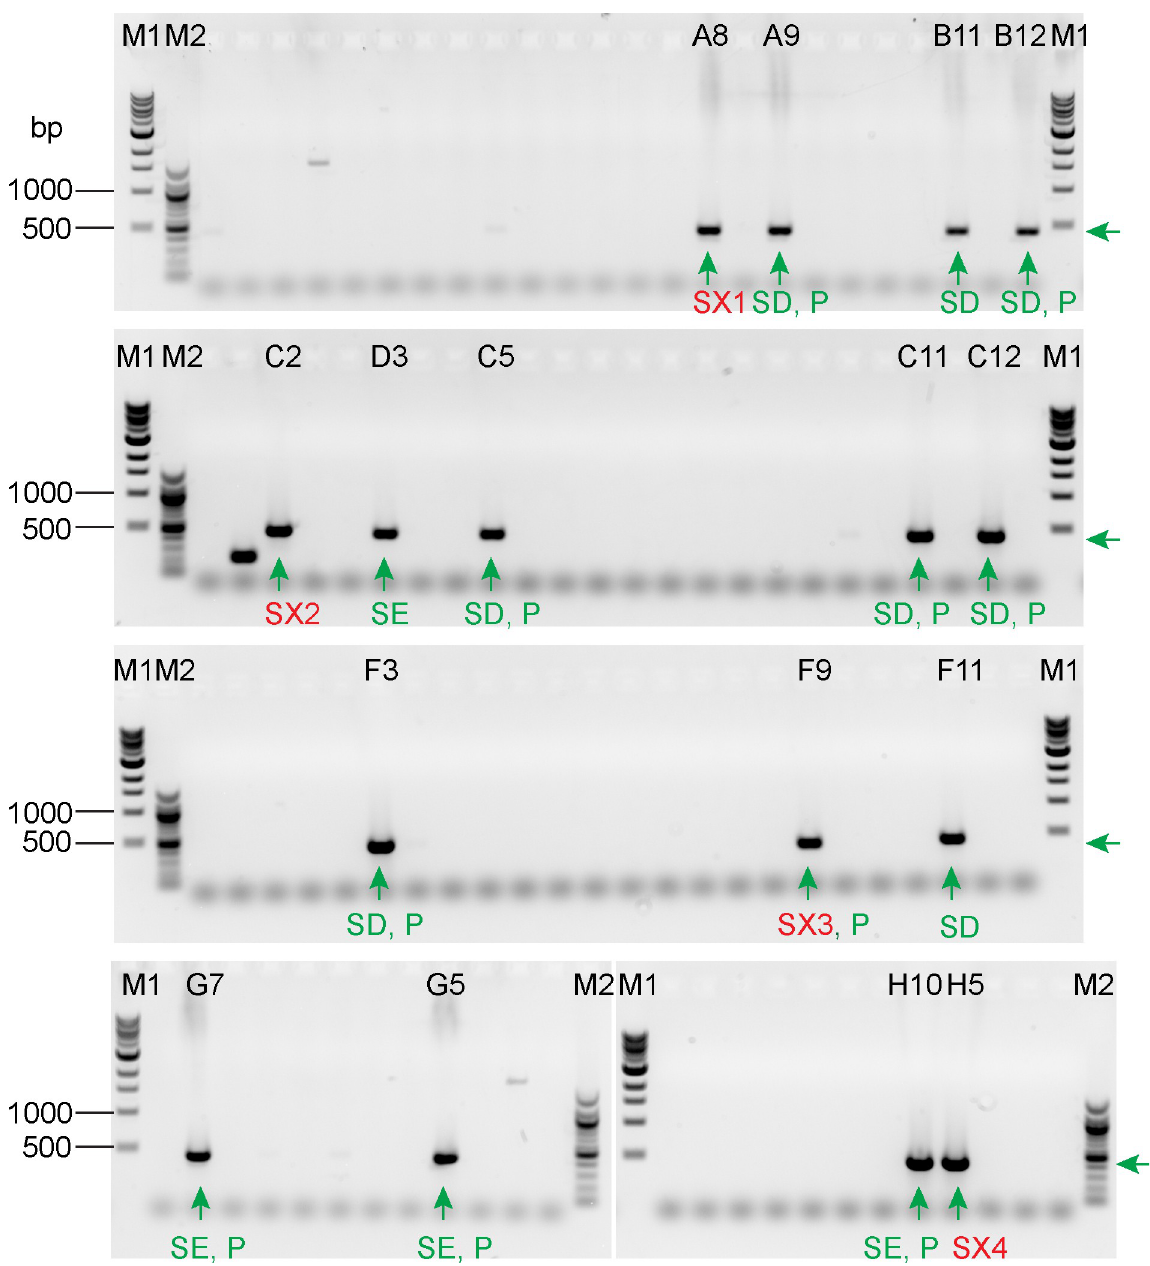
Fig 8. PCR screening of transformants for insertion of the 3’ end of the NAP1L1 mNeonGreen-3xFLAG donor DNA at the RNP2 cut site. Crude DNA preparations from 96 transformants were used as templates for PCR amplification with primer pair P1/P2 as illustrated in Fig 4. Since P1 is complementary to the tag sequence, no PCR product is expected for the wild-type gene. The expected size for product from a correctly tagged gene is 450 bp. The presence of product of a size other than 450 bp indicates that more complicated editing occurred. Sixteen clones (labeled A8-H10) yielded product of the size expected for a correct edit (green arrows below the bands and on the right side of the gels); the PCR products from these clones were sequenced for further confirmation (S3 Appendix). Eight of the 16 (marked with green SD) had a sequence that was exactly as expected if the donor DNA was used as the repair template, whereas four (marked with green SE) had a sequence that was exactly as expected if the endogenous DSB end was used as the repair template. In the remaining four (red SX1-SX4), indel or point mutations had been introduced. Ten clones subsequently found to express NAP1L1 tagged with mNeonGreen-3xFLAG (see Fig 11) are marked with a green P. M1: NEB 1 kb DNA ladder (catalog number NO552). M2: NEB 100 bp DNA ladder (catalog number NO551). The band sizes from top to bottom for M1 are 10, 8, 6, 5, 4, 3, 2, 1.5, 1, and 0.5 kb. The band sizes from top to bottom for M2 are 1517, 1200, 1000, 900, 800, 700, 600, 500/517, 400, 300, 200, and 100